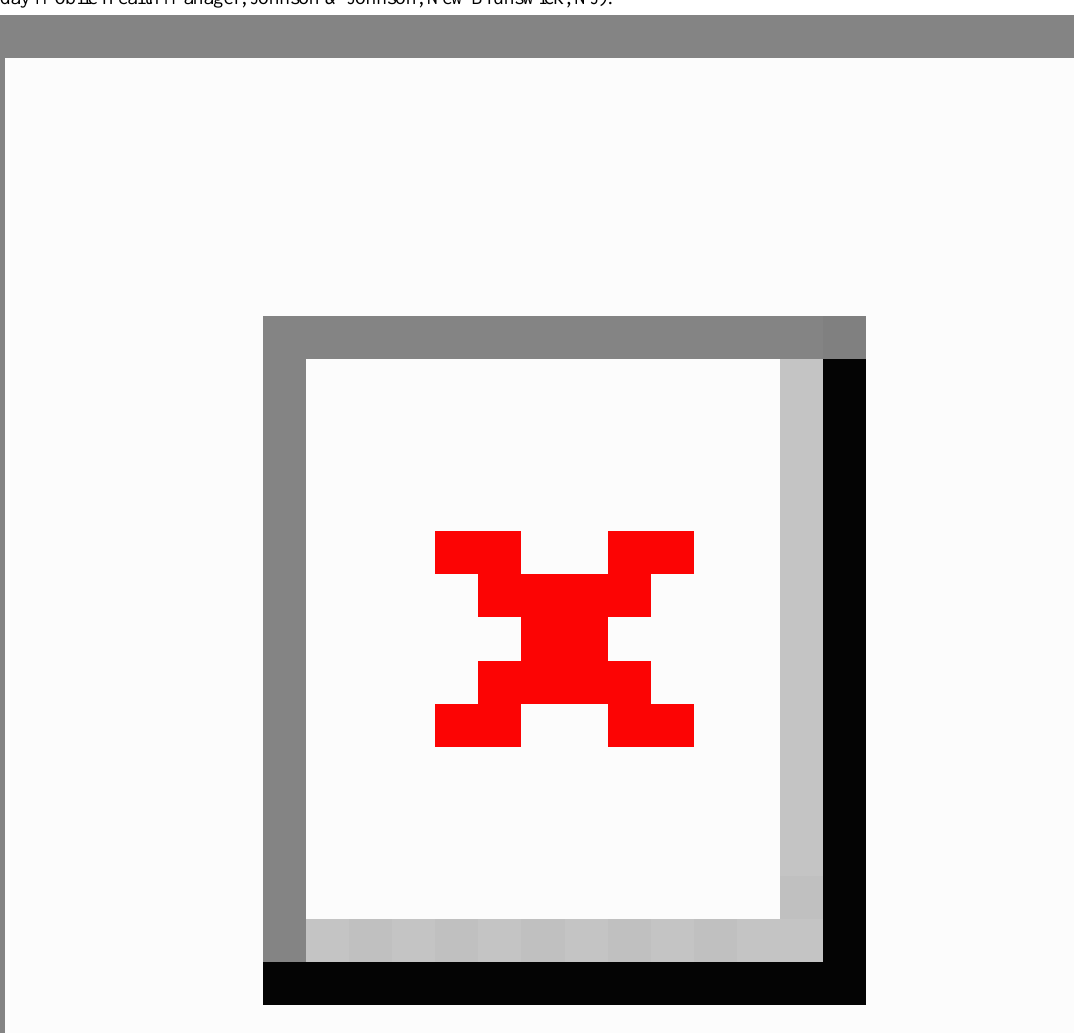
Figure 1. Representative user-facing image for the mobile health app visual for antiretroviral medications as seen in the smartphone program (source: Care4Today Mobile Health Manager, Johnson & Johnson, New Brunswick,